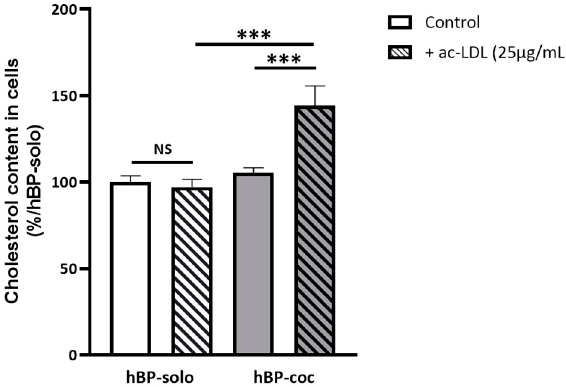
Figure 6. Cholesterol content in hBP-coc is increased after acetylated LDL (ac-LDL) treatment only. After 6 days of culture, hBP-solo and hBP-coc were treated 3 h with or without 25 µ g/mL of ac-LDL and their cholesterol content were measured and normalized by µ g of proteins. Each bar represents the mean ± SEM ( n = 6–9). Statistical analysis: One-way ANOVA with Bonferroni’s multiple comparison test, NS: non-significant, ***: p < 0.001.